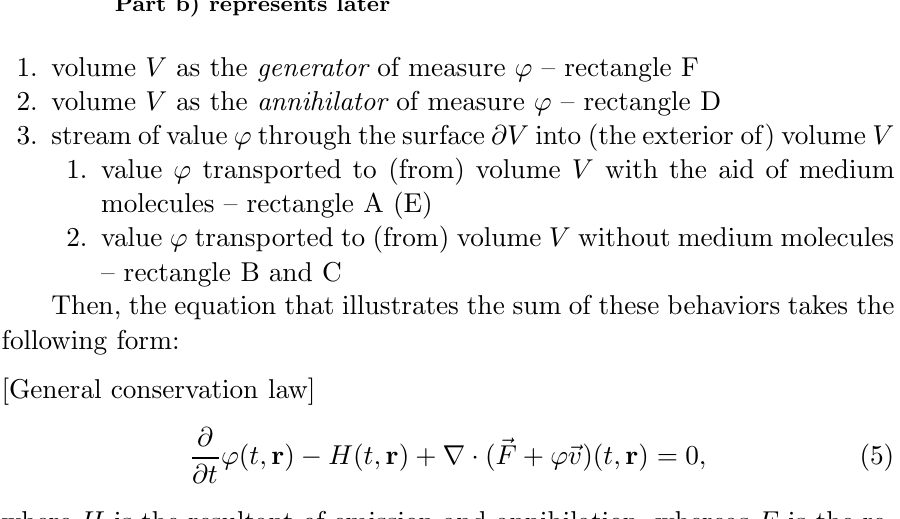
Figure 4. Transportation diagram for the value ϕ . Medium molecules are marked with spheres, and values ϕ are marked with rectangles. Part b) represents